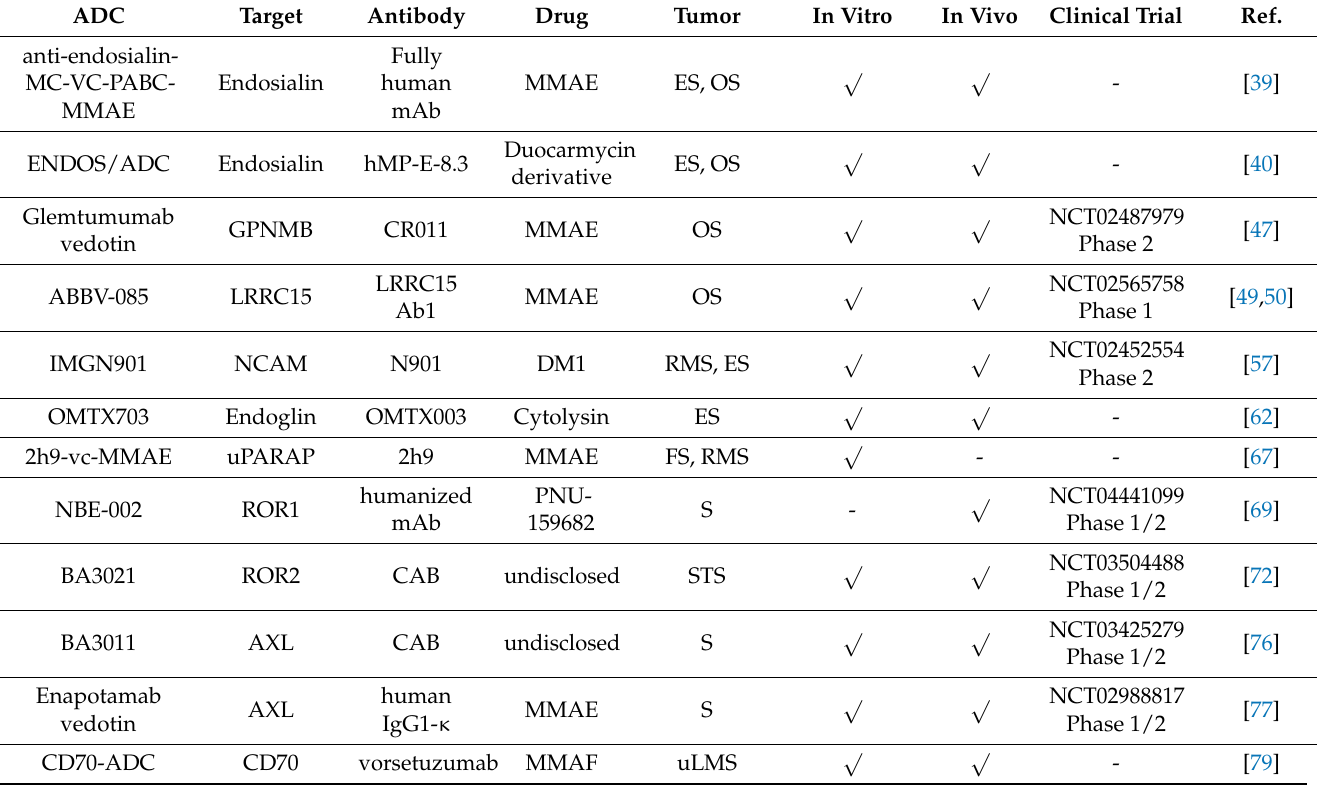
Table 1. Antibody–drug conjugates tested for sarcoma